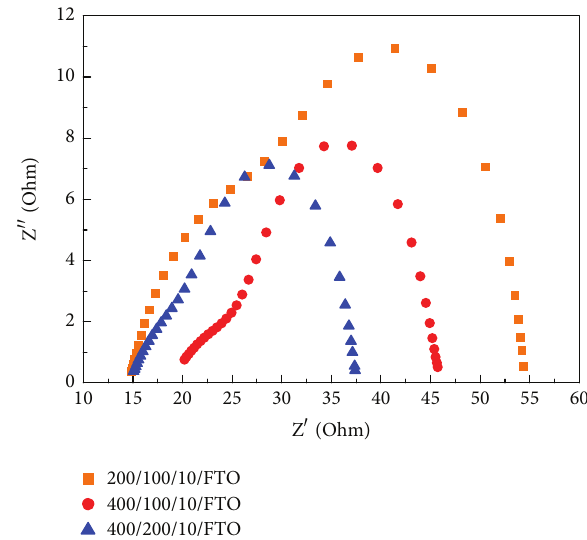
Figure 10: The photocurrent-voltage curves of DSSCs with triple- layer structure of TiO 2 layers.